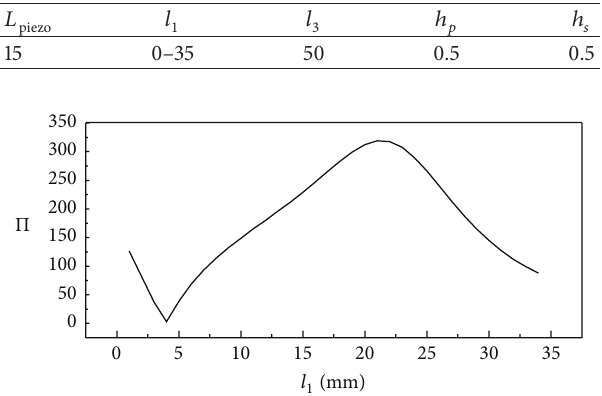
Table 4: Dimension parameters of the vibrator (mm).